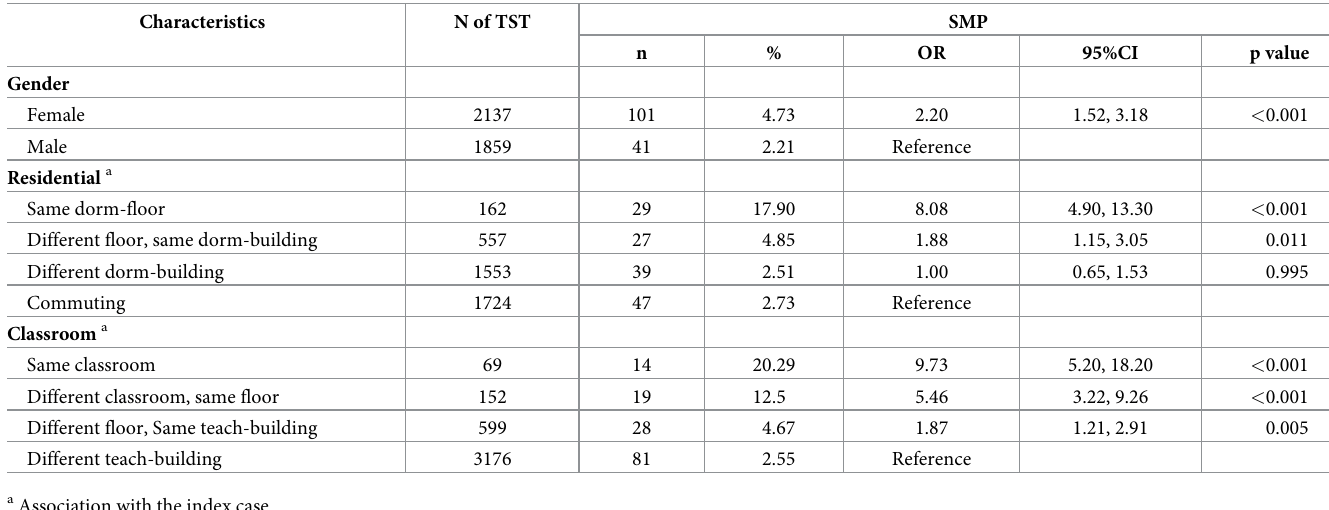
Table 5. Distribution, unadjusted OR and 95% CI for characteristics of students on SMP. Characteristics